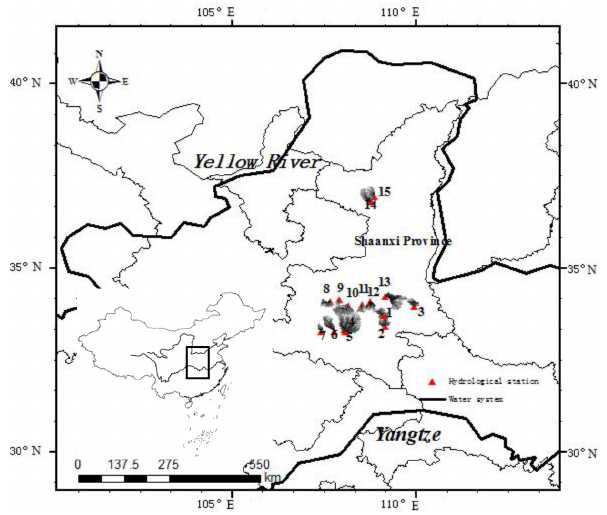
Figure 1. Locations of the study sites. Figure 2. Schematic flow chart of study